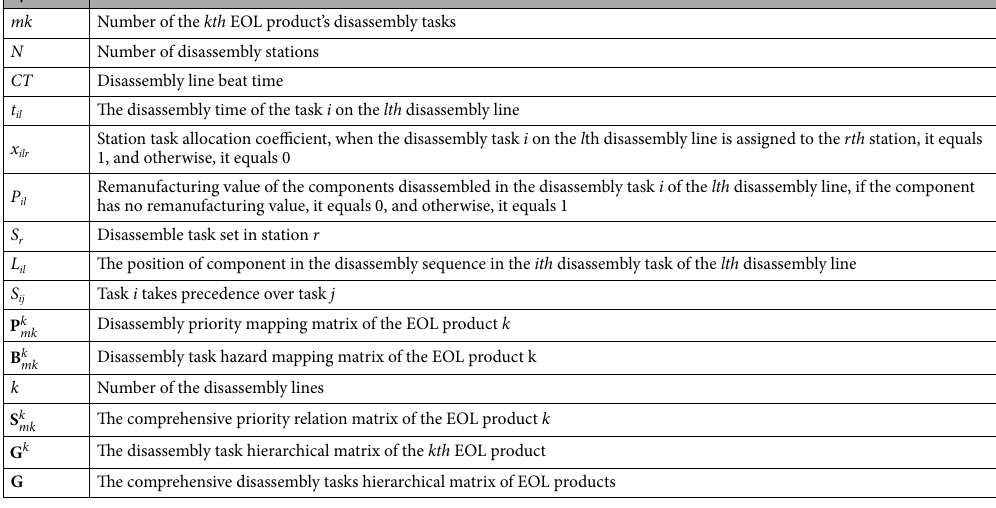
Table 1. Symbol definitions.